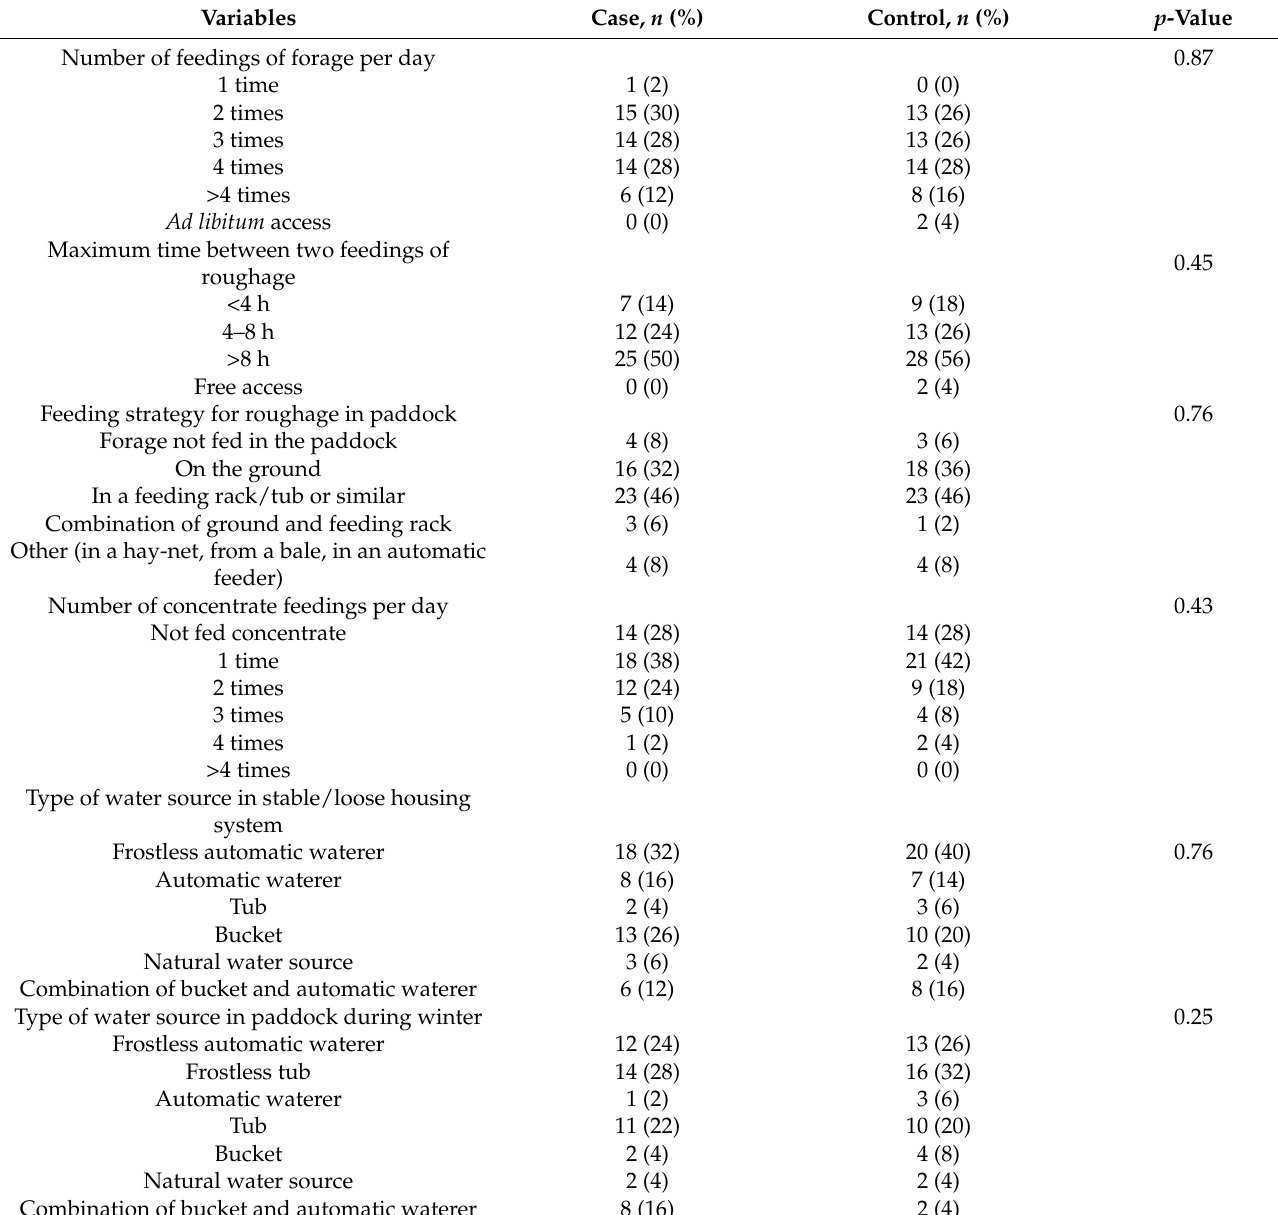
Table 3. Distribution of feeding strategies of farm-matched pairs of horses with (case, n = 50) and without (control, n = 50) free faecal liquid. Variables Case, n (%) Control, n (%) p -Value Number of feedings of forage per day